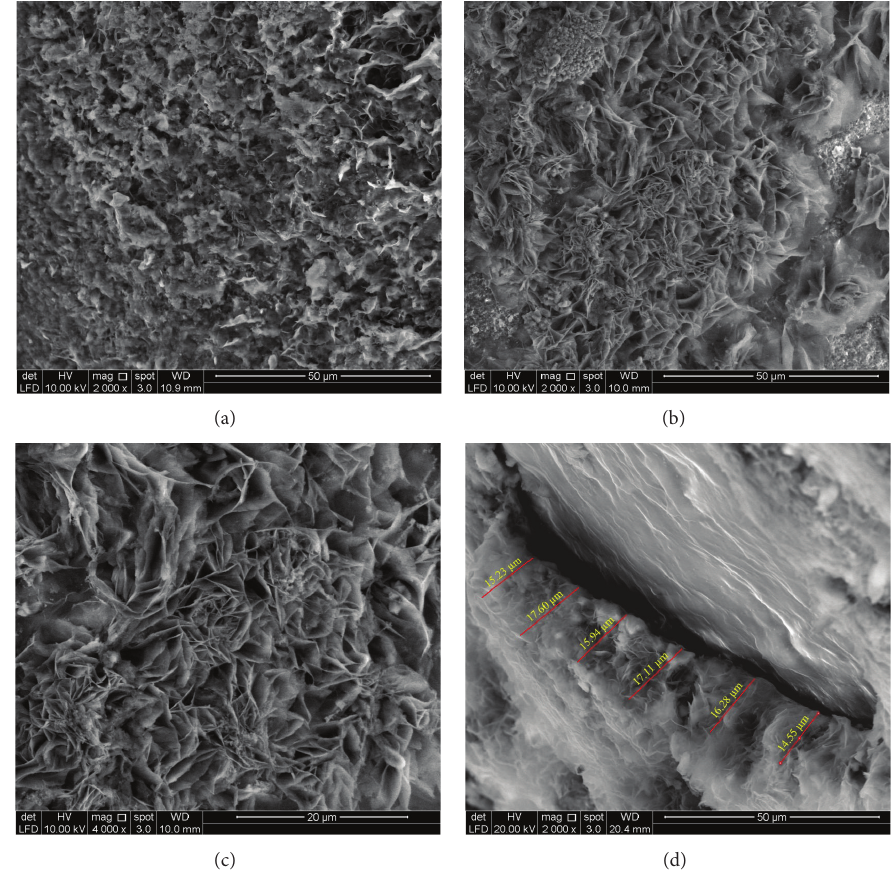
Figure 4: SEM morphological surface of coated GP with different magnifications (a), (b), and (c). (d) shows the coating thickness.